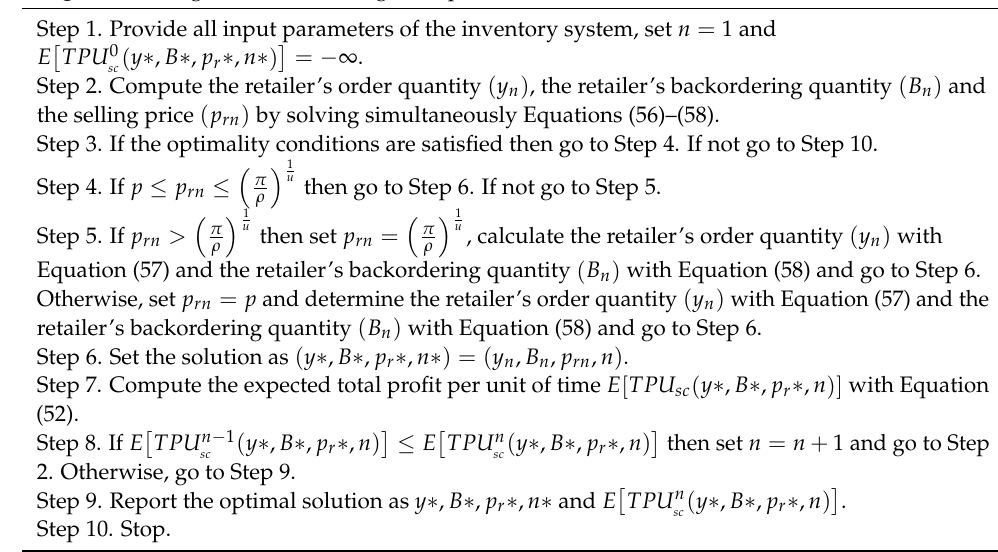
Algorithm 1 Algorithm for Finding the Optimal